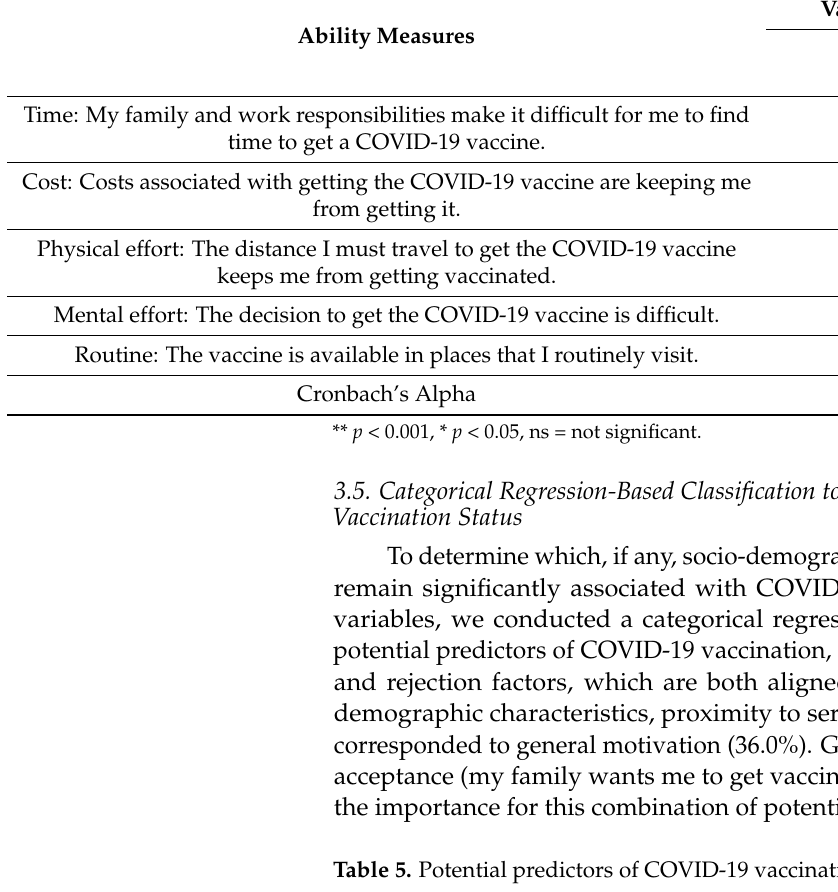
Ability Measures